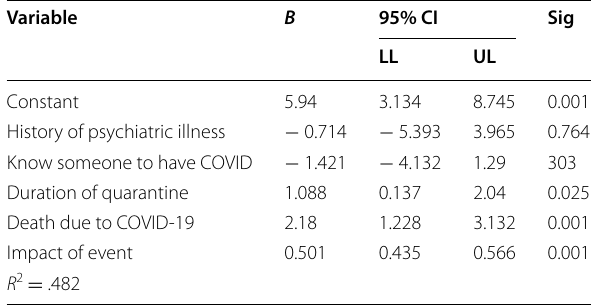
Table 3 Predictors of depression using Center of Epidemiologic Study‑Depression among respondents after the first wave of COVID‑19